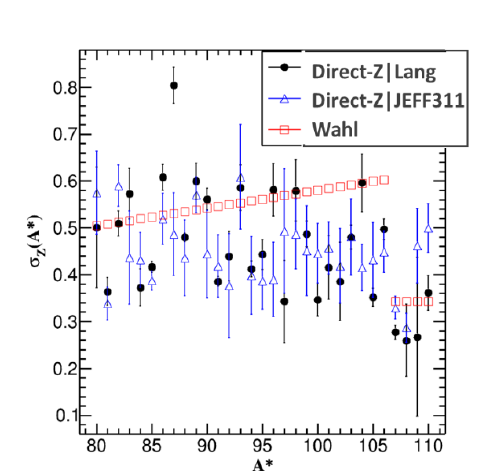
Fig. 14. The evolution of the pre-neutron emission  Z (A * ), in black the data determined via the adjustment based on Lang results, in blue the data determined via the adjustment based on JEFF-3.1.1 library and in red the data of Wahl’s systematics